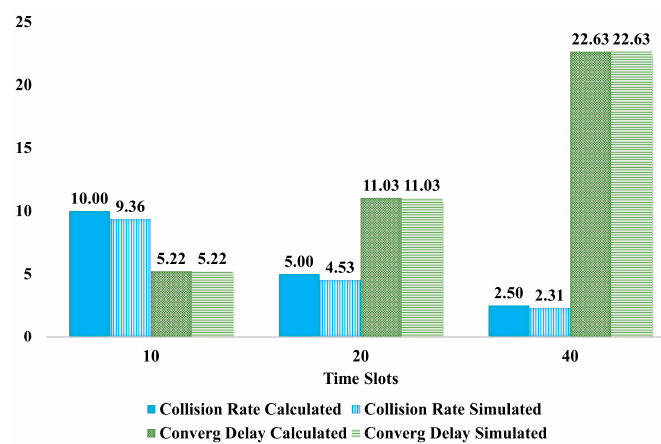
Figure 18. Collision Rate vs. Convergence Delay.